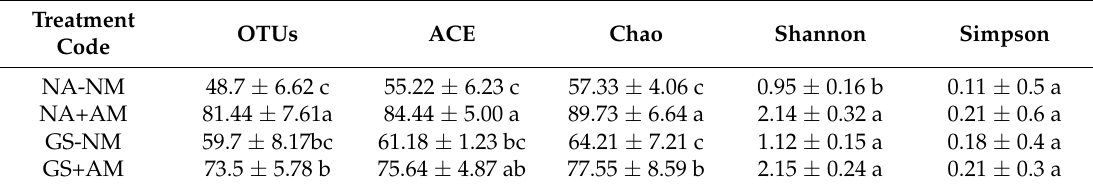
Table 7. Comparison of the estimated OTUs richness and diversity indices of AMF clustering at 97% identity, as obtained from the Illumina MiSeq sequencing under different soil samples.